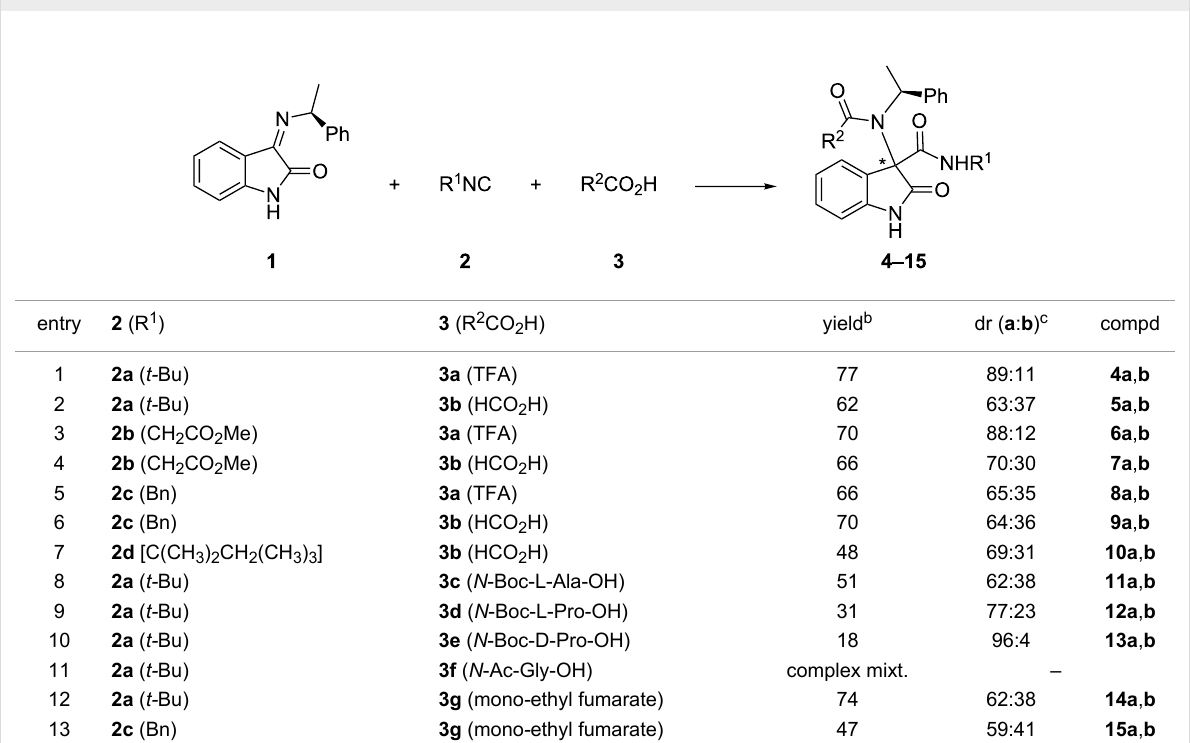
Table 2: Reaction of imine 1 with different isocyanide and acid components.